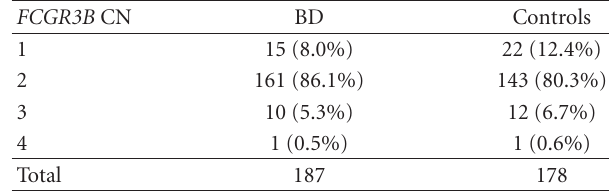
Table 2: Distribution of FCGR3B copy number (CN) variants in Behc¸et’s (BD, N = 187) patients and controls ( N = 178).